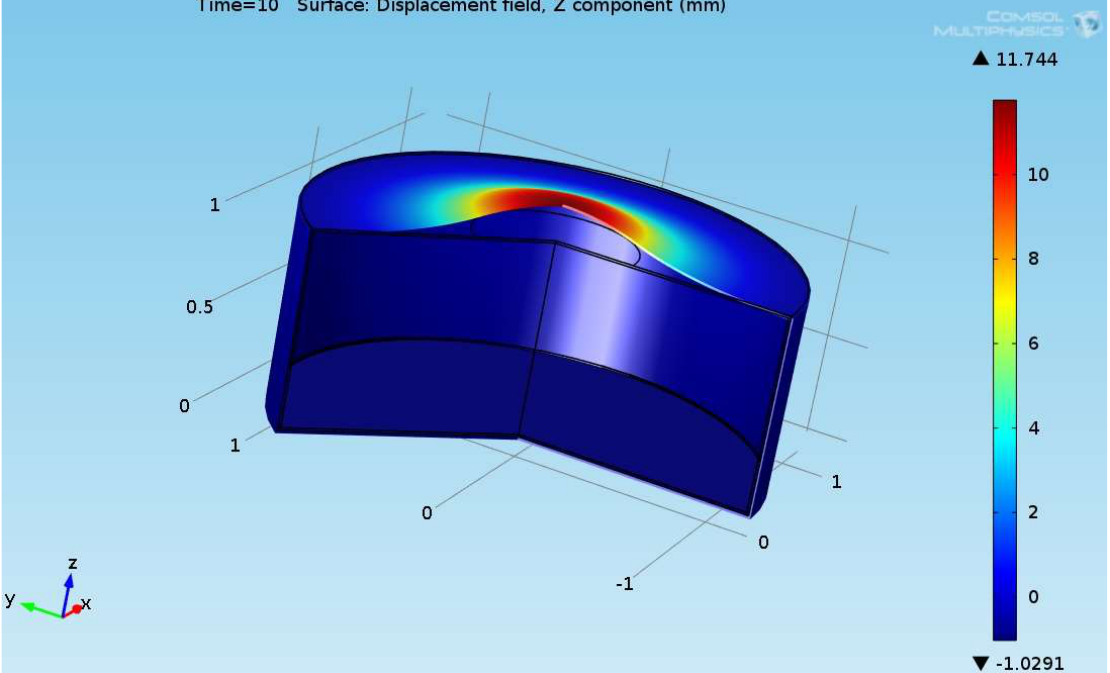
Figure 15. 3D plot of the Propane tank Von-Mises stress field obtained at t = 10 s.